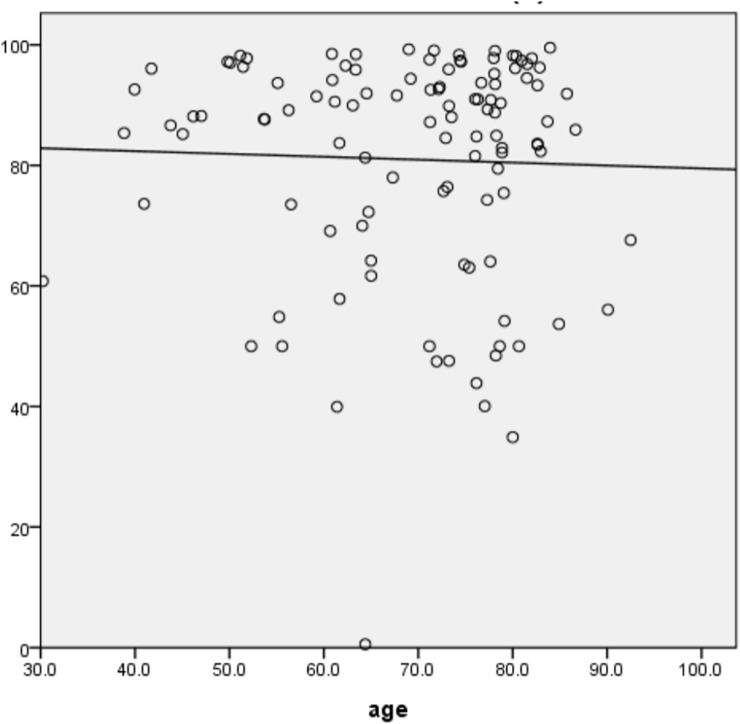
Distribution of LINE-1 methylation level in different age group.X axis: age. Y Axis: Line-1 methylation, expression with percentage.